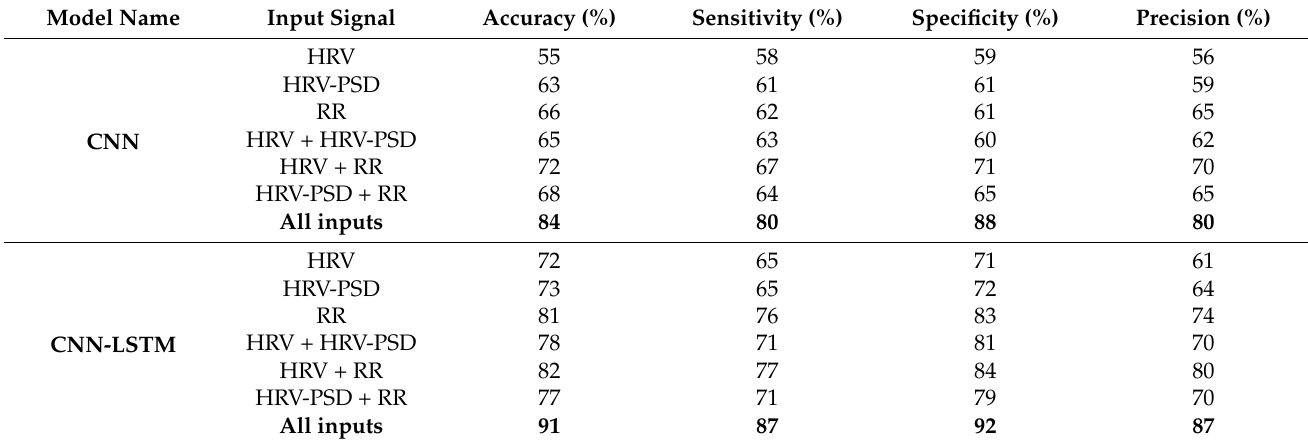
Table 2. Performance of the CNN and the CNN-LSTM models for the three-level drowsiness classifi- cations for different combinations of input signals.